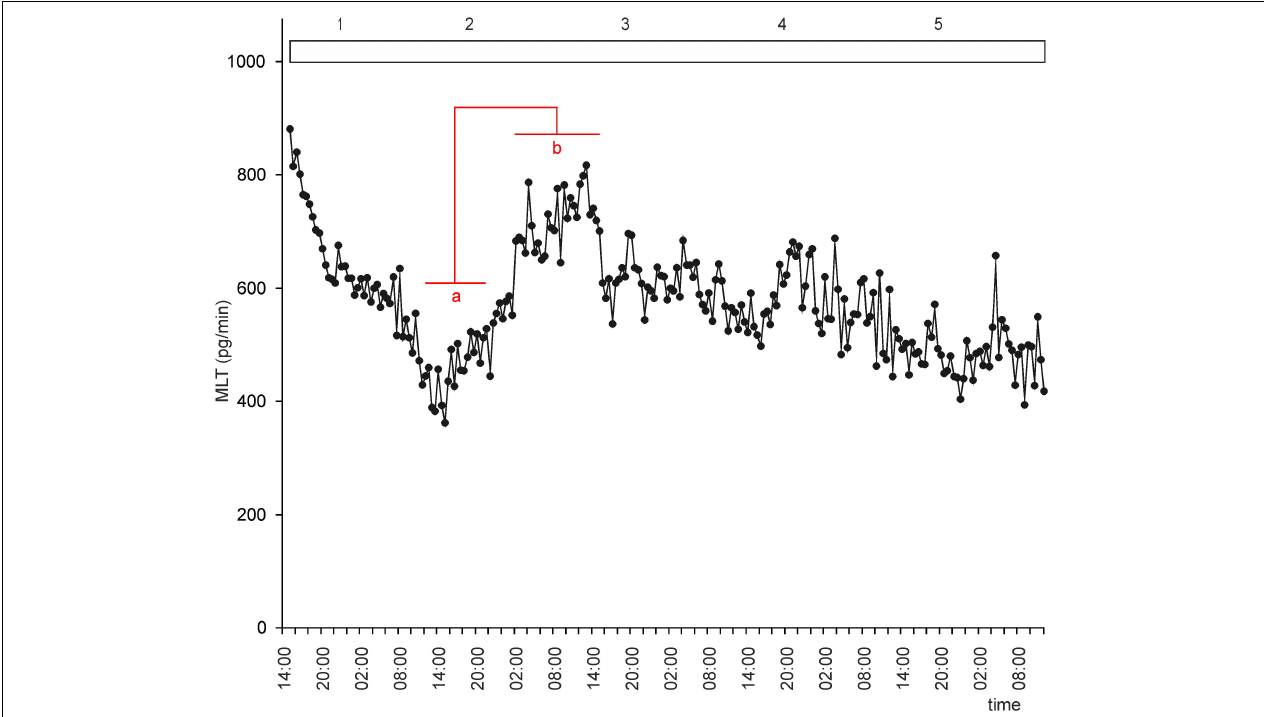
FIGURE 5 | Secretion (means, n = 4) of MLT by goose pineal organs incubated in continuous light for 5 days. Horizontal red lines show periods, when the means differ significantly ( p < 0.05) between sampling time-points (repeated measures ANOVA and LSD